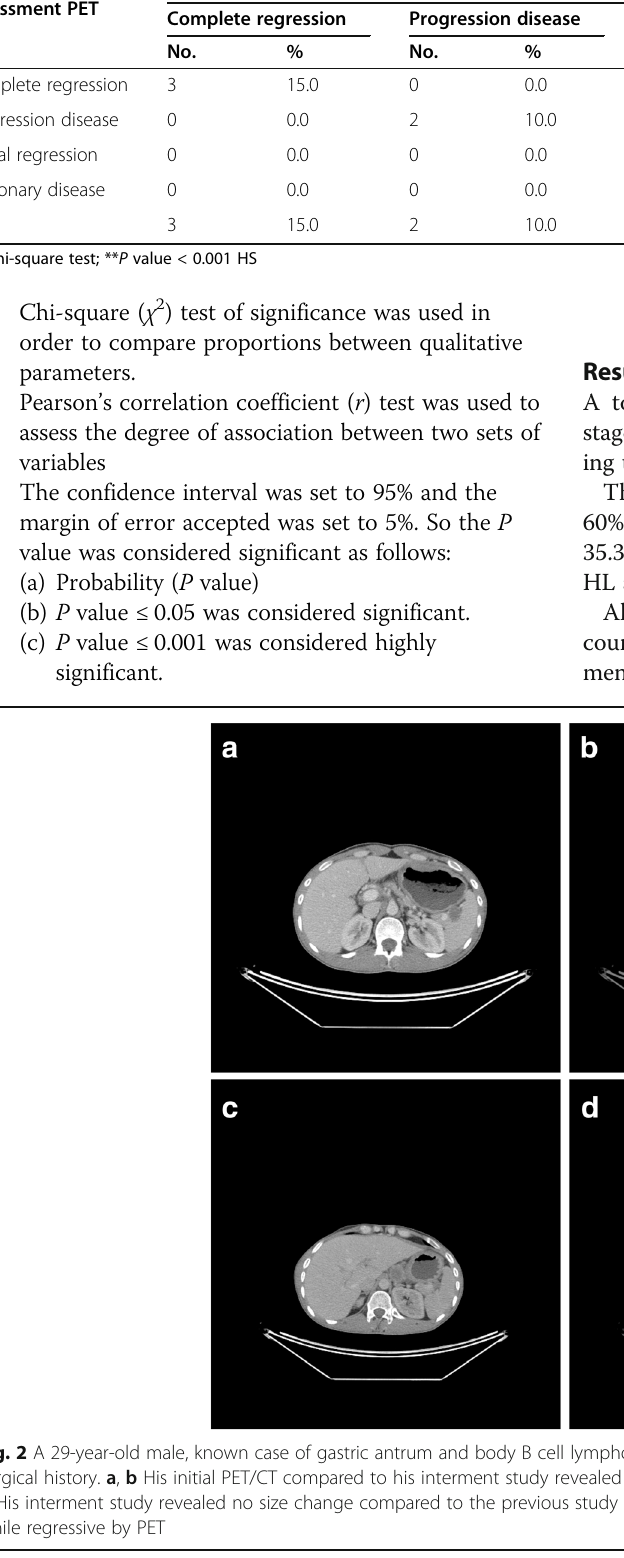
Table 6 Relation between treatment assessment at CT and treatment assessment at PET-CT of the study group Treatment assessment PET